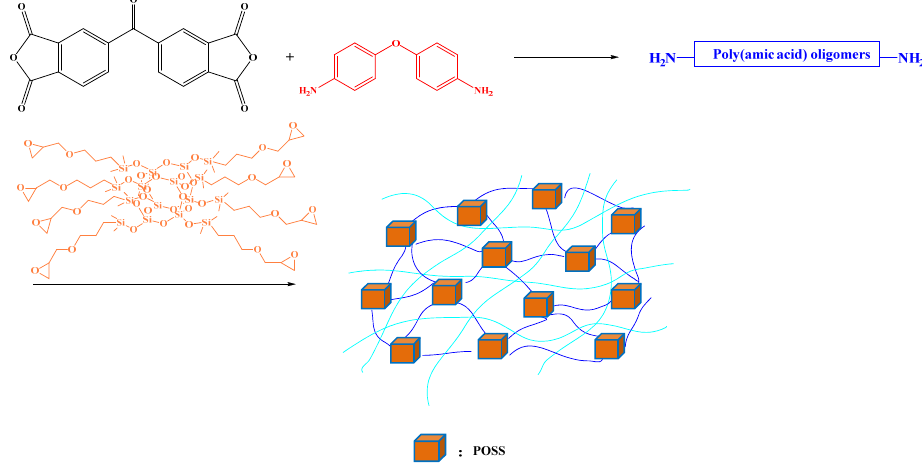
Figure 14. Preparation of OG-POSS cross-linked PIs [83]. Reproduced with permission from Elsevier.